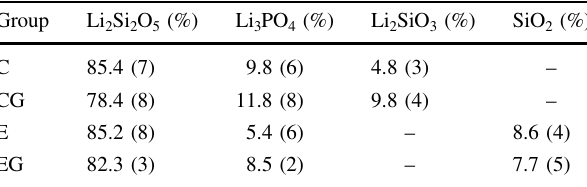
The standard deviation of the measurements is shown in parentheses